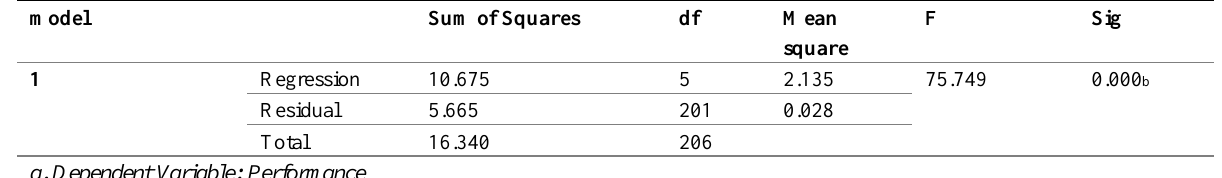
Table 5: Analysis of variance